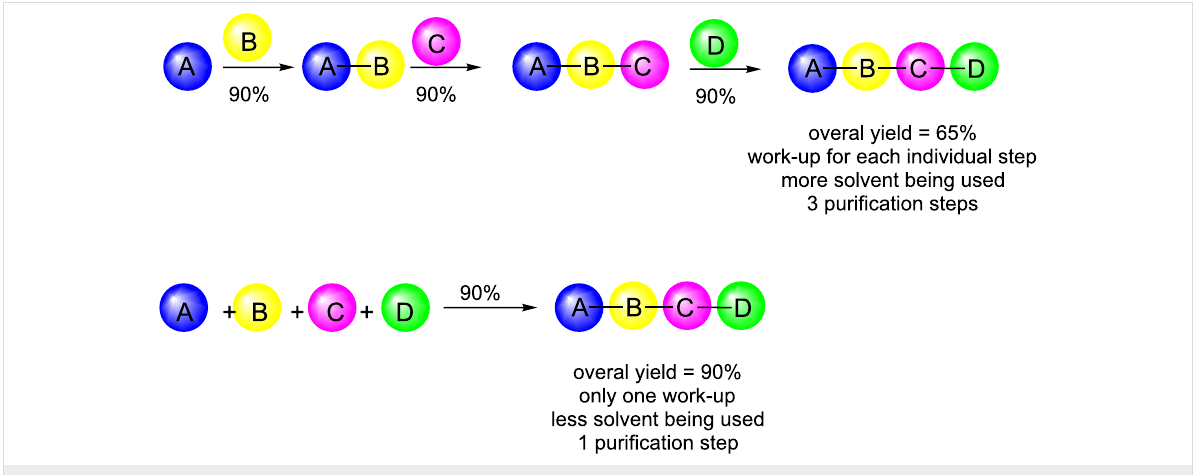
Scheme 1: Comparison between a normal sequential reaction and an